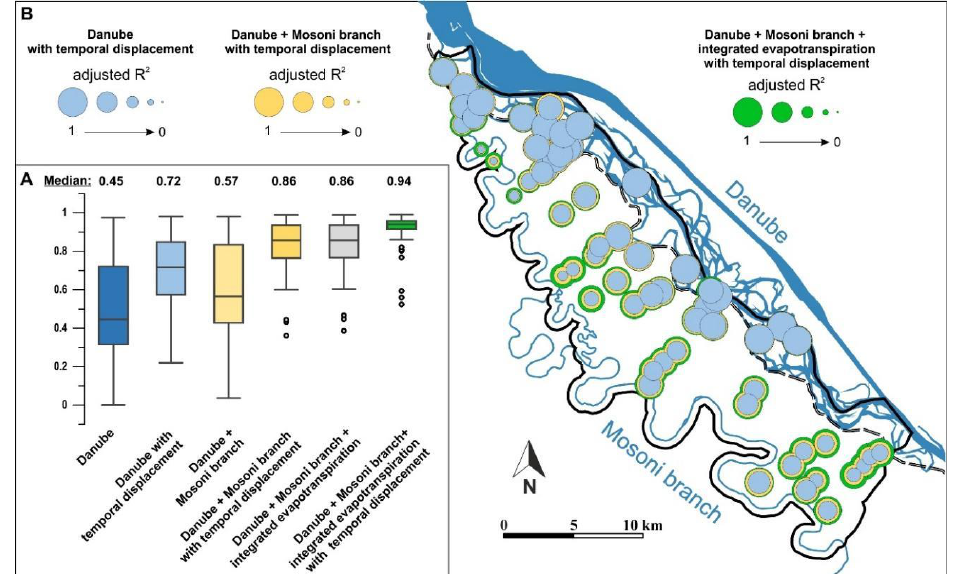
Figure 7. Box-and-whiskers plots of the R 2 values ( A ) and their spatial distribution ( B ) in relation to the given set of independent variables (blue: based on only the displaced Danube gauge, yellow: displaced Mosoni gauge included, green: integrated evapotranspiration also included).